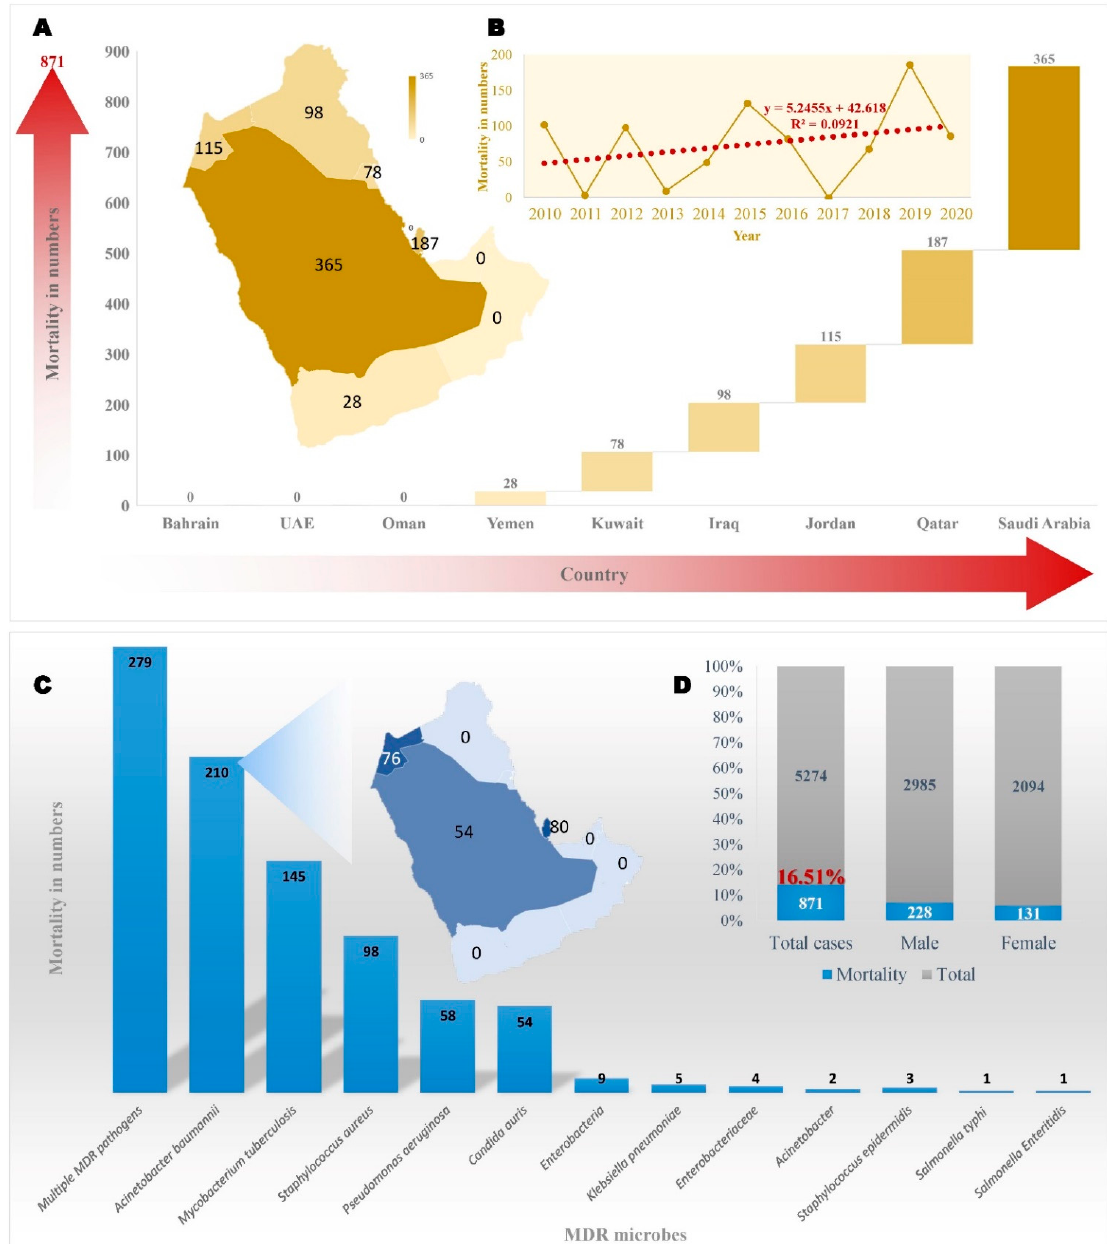
Figure 3. ( A ) Multidrug-resistant microbial associated mortality reported in the Arabian Peninsula. ( B ) Dark red line indicates linear trend line of annual mortality due to multidrug-resistant microbial infection. ( C ) Number of deaths reported due to specific MDR microbial infection in Arabian Peninsula. Map in blue color indicate the country wise mortality due to Acinetobacter baumannii . ( D ) Percentage mortality due to MDR microbes. Gender information were not reported on the mortality in certain articles. UAE: United Arab Emirates.